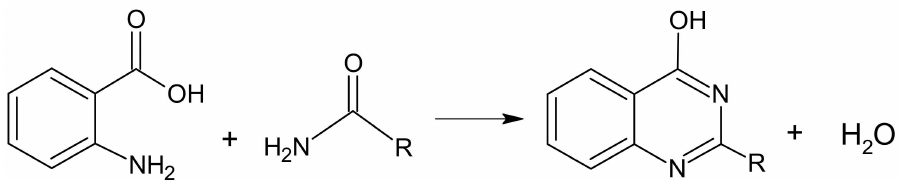
Figure 1. Niementowski synthesis of quinazolinones